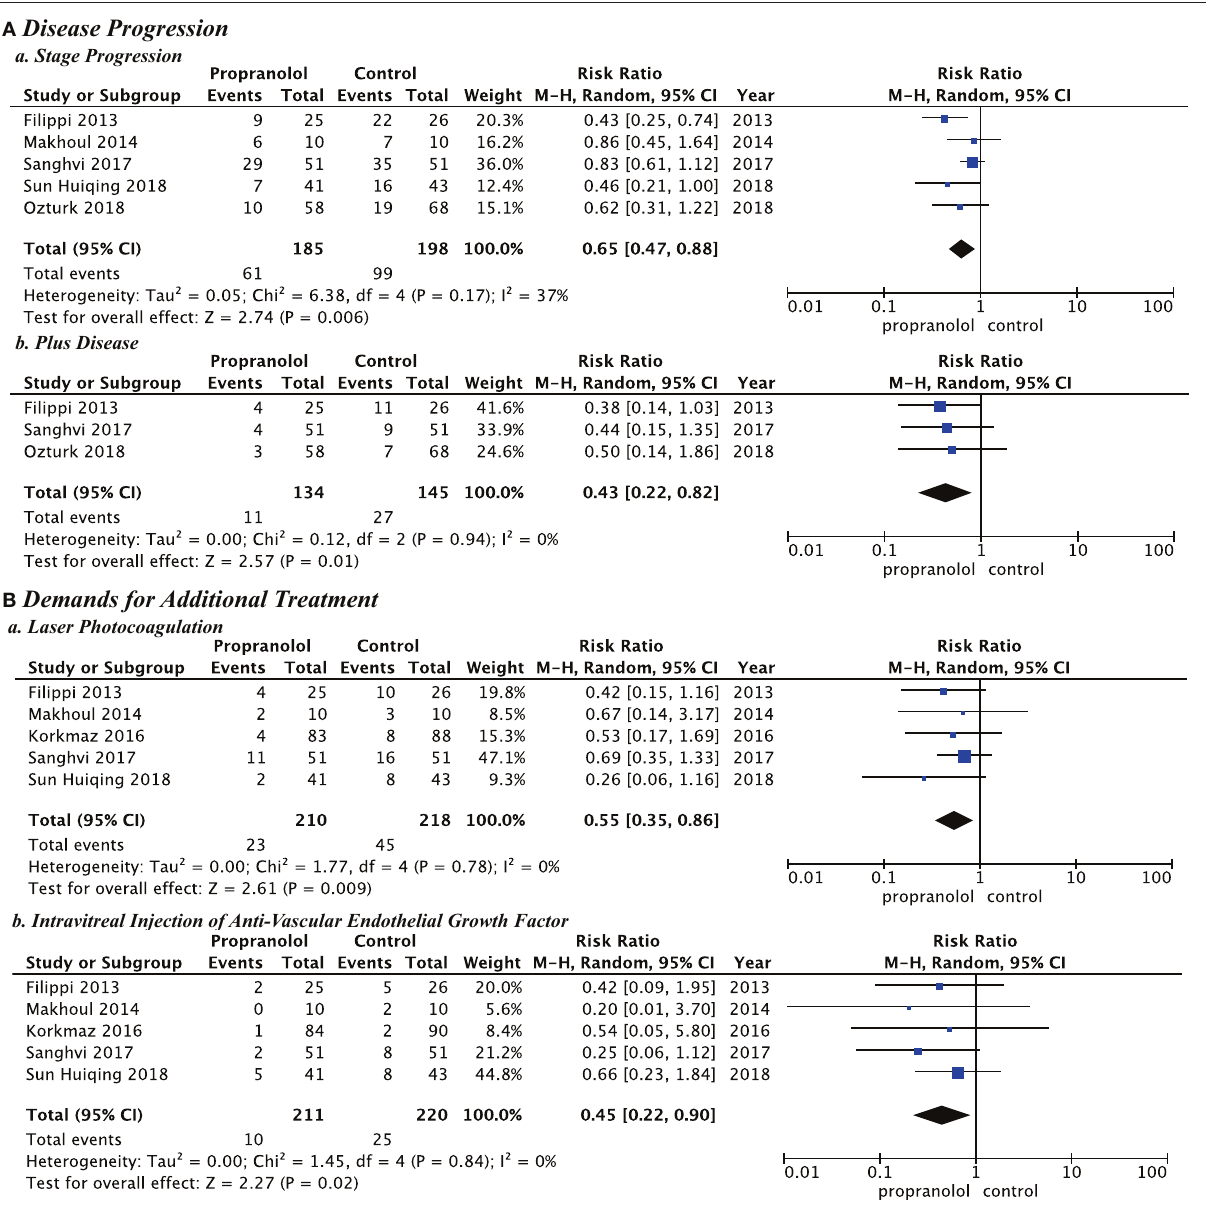
Frontiers in Pediatrics |